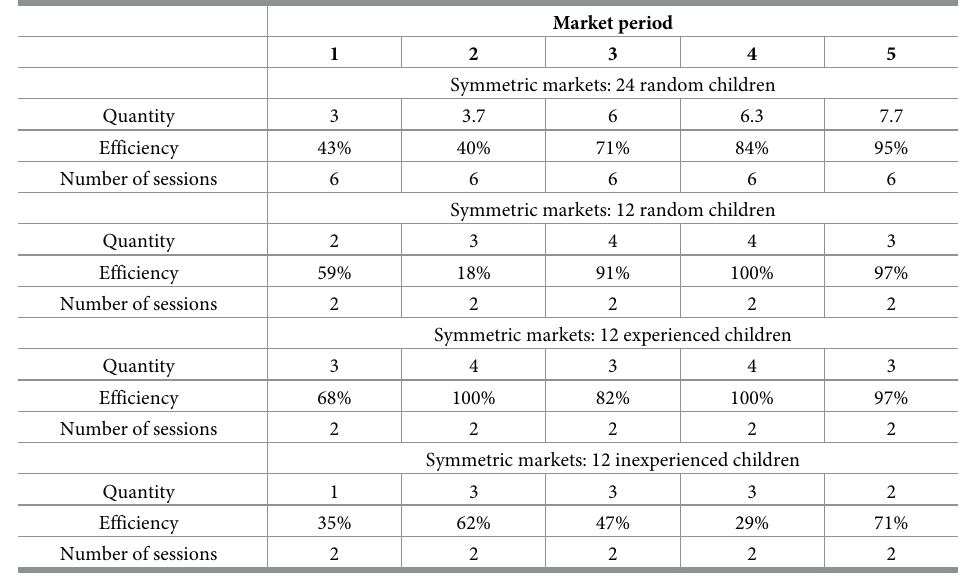
Table 2. Sample statistics for children from Experiment 1 in